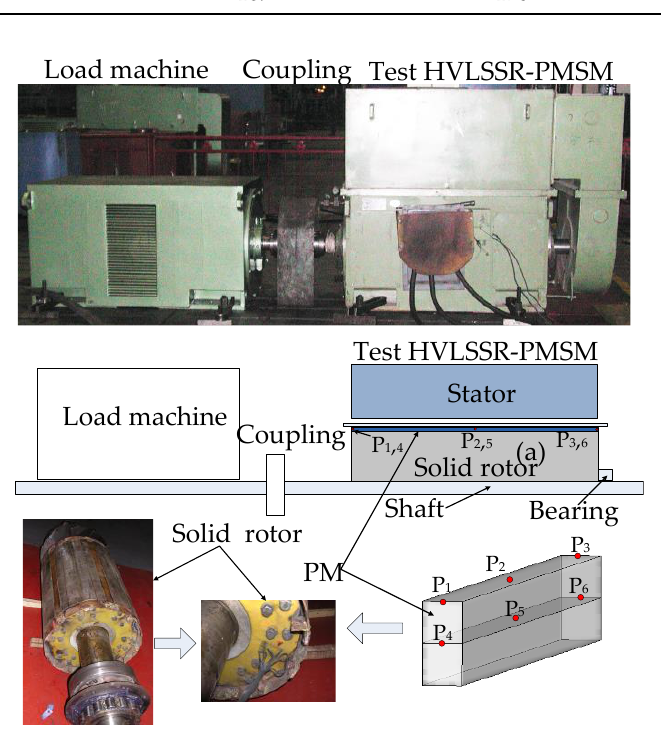
Figure 14. Experimental test bench (HVLSSR-PMSM). Table 6. Comparison of temperature data of stator end windings (°C).